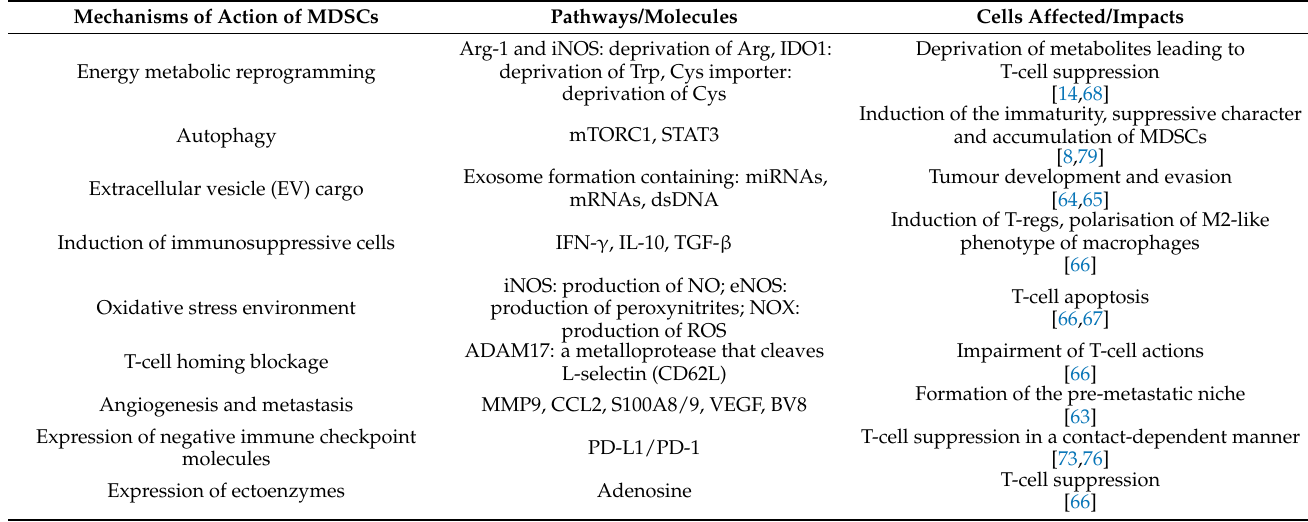
Table 2. Overview of the mechanisms of the immunosuppressive action of